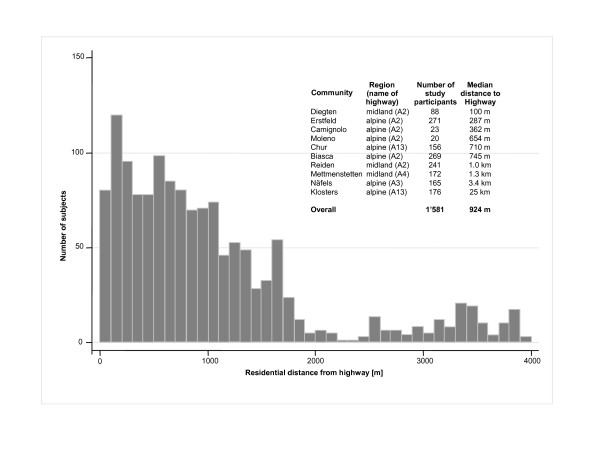
Distribution of residential distances from highway for the MfM-U study population in 2005. The histogram shows data from subjects living within 4 km of the highway.